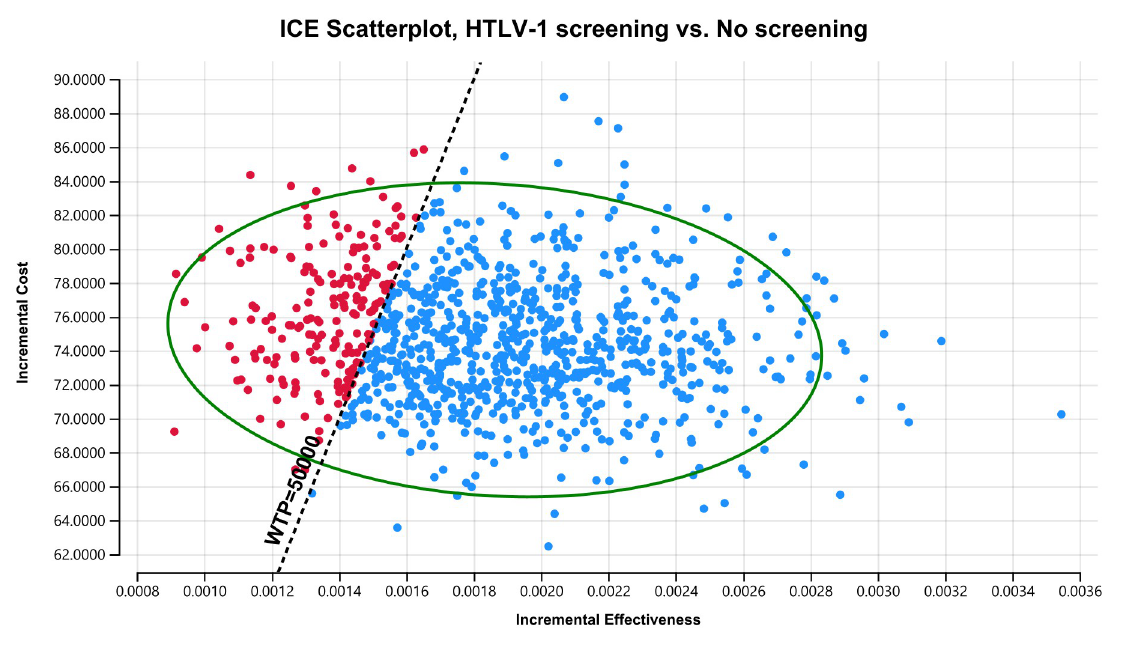
Fig 5. ICE scatterplot with a 95% confidence ellipse at a WTP threshold of US$50,000 per QALY gained. Each dot represents a single simulation for a total of 1000 simulations. The ICE scatterplot showed that HTLV-1 antenatal screening is dominant in 811 trials to no screening in 1000 trials. ICE, incremental cost-effectiveness; QALY, quality-adjusted life-year; WTP, willingness-to-pay; HTLV-1, human T cell leukemia virus 1.